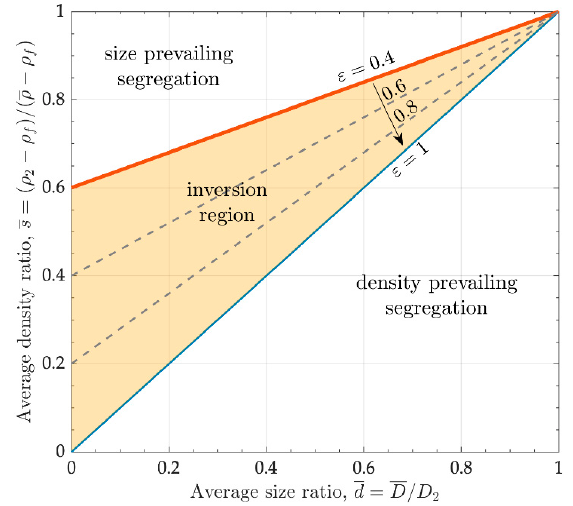
Figure 2. Layer inversion zone in the average density vs. average diameter ratio map. Three distinct regions appear: the one where the denser component tends to settle and the lighter one tends to float (density prevailing); the one where the finer component tends to float and the bigger one to settle (size prevailing); the intermediate region where the segregation direction can change with expansion (layer inversion).